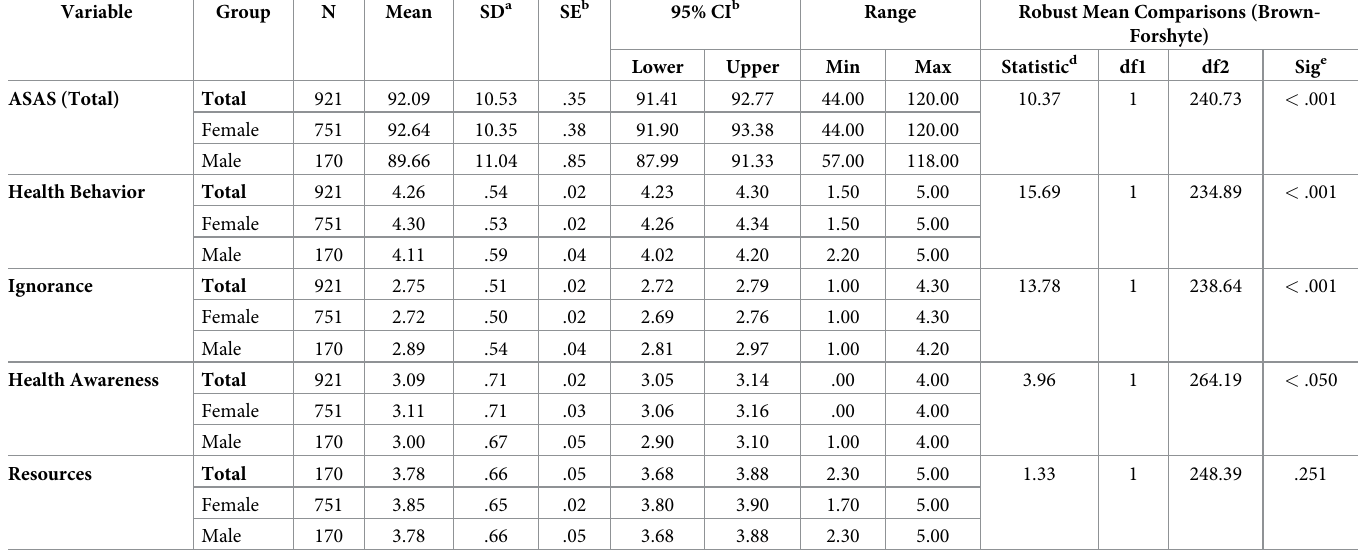
Table 2. Descriptive values and gender-based robust mean comparisons of the ASAS and its main